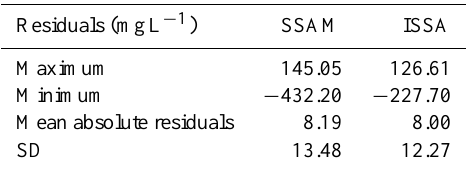
Table 2. Maximum, minimum and mean absolute residuals of SSAM and ISSA.